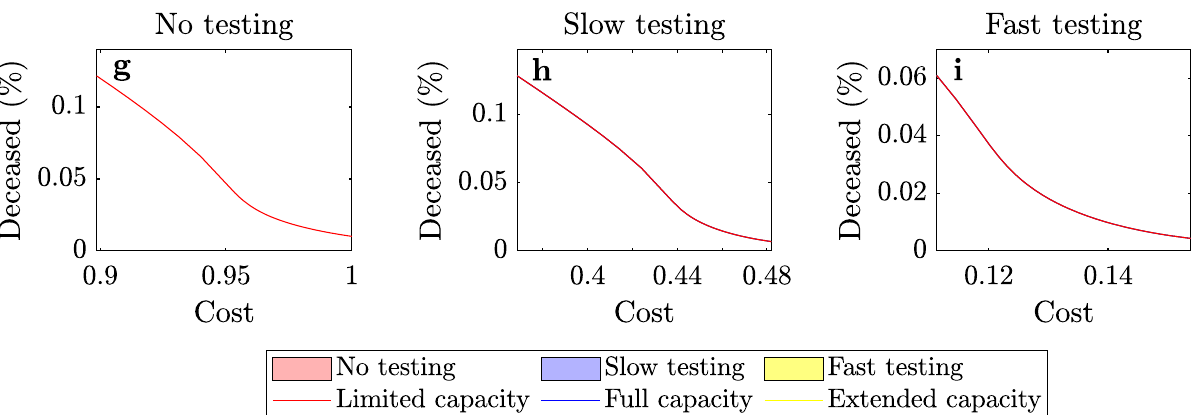
Figure 2. Deceased population vs. cost. Proportion of deceased population versus cost of optimal government intervention when the available healthcare capacity for COVID-19 patients is limited (red), full (blue), and extended (yellow) and when no testing ( a,d,g ), slow testing ( b,e,h ) and fast testing ( c,f,i ) policies are adopted. In addition, we present the cases where no emphasis ( a–c ), low emphasis ( d–f ) and high emphasis ( g–i ) is given to the cost associated with the acutely symptomatic population. When identical relations are obtained for different healthcare capacity levels, as in ( e–i ), then only the lowest capacity is presented. Shaded regions show the ranges of the relations between deceased population percentage and cost of government interaction when the healthcare capacity is between the limited and extended levels. All presented costs are normalised using as basis the cost of the optimal government strategy with no testing resulting to 0.01%